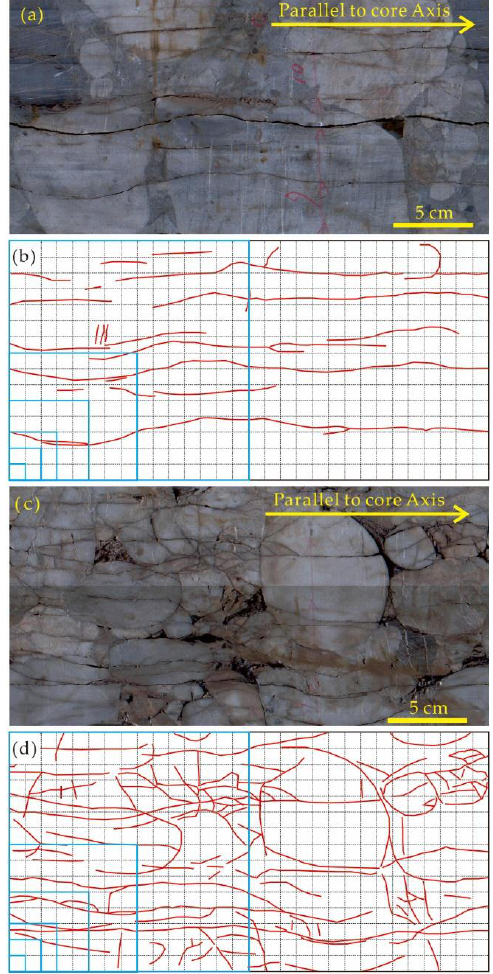
Figure 2. Core images, fracture traces and meshes. ( a ) Image of the surface of core A; ( b ) fracture traces of core A and the grids for box-counting; ( c ) image of the surface of core B; ( d ) fracture traces of core B and the grids for box-counting. The side length of the blue boxes is 1 cm, 2 cm, 3 cm, 5 cm, 8 cm, 10 cm and 15 cm, respectively.